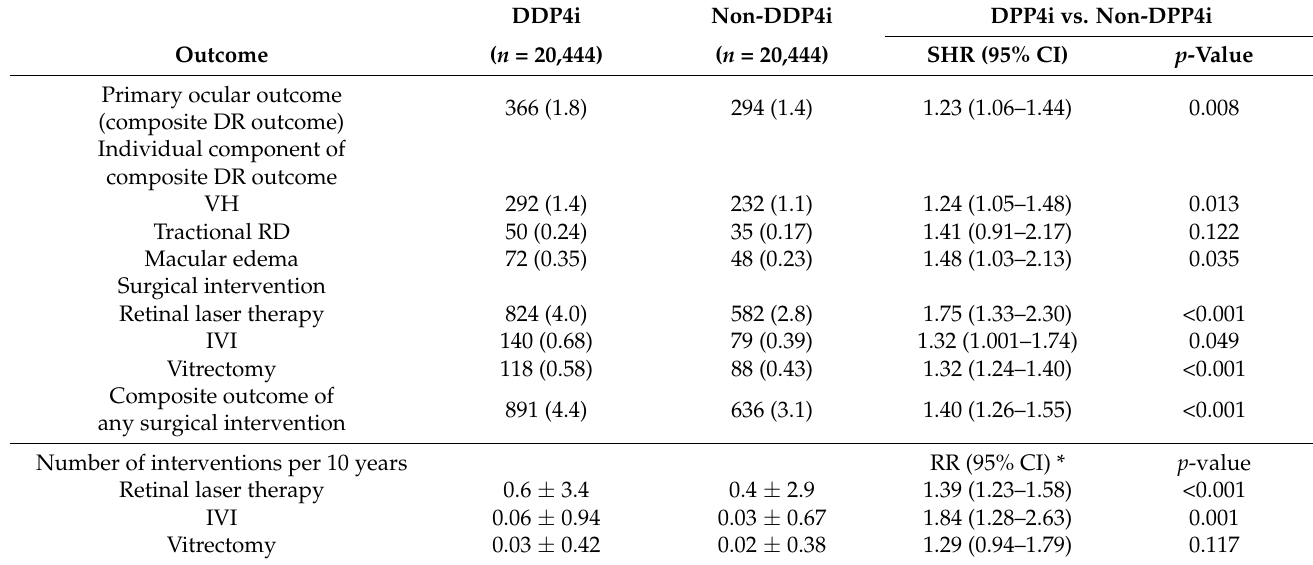
Table 2. Primary ocular outcomes, including any surgical intervention taken, of patients with type 2 diabetes and diabetic retinopathy demonstrating significantly higher risks of composite diabetic retinopathy and surgical interventions in the DPP4i group.